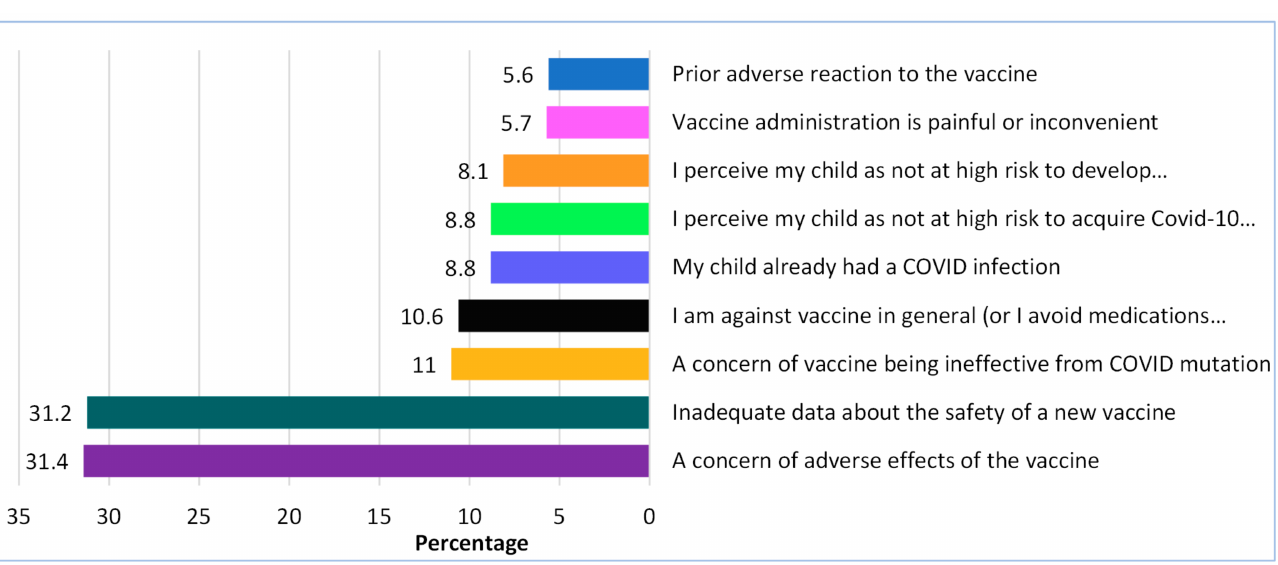
Figure 1. Reasons for parents’ decision on children’s vaccine hesitancy.